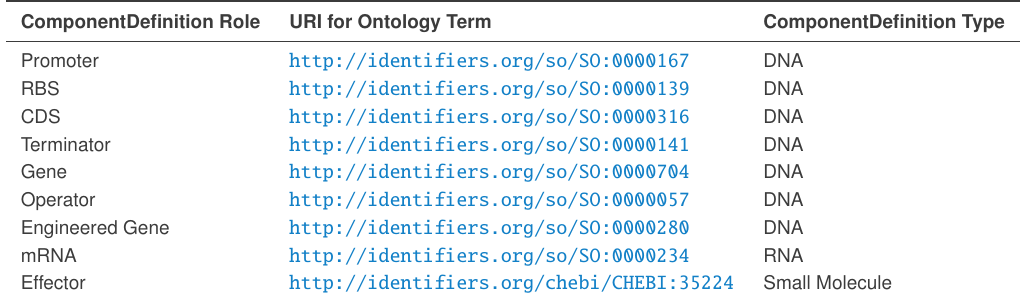
Table 4: Ontology terms to specify the roles property of a ComponentDefinition , organized by the type of ComponentDefinition to which they are intended to apply (see Table 2).